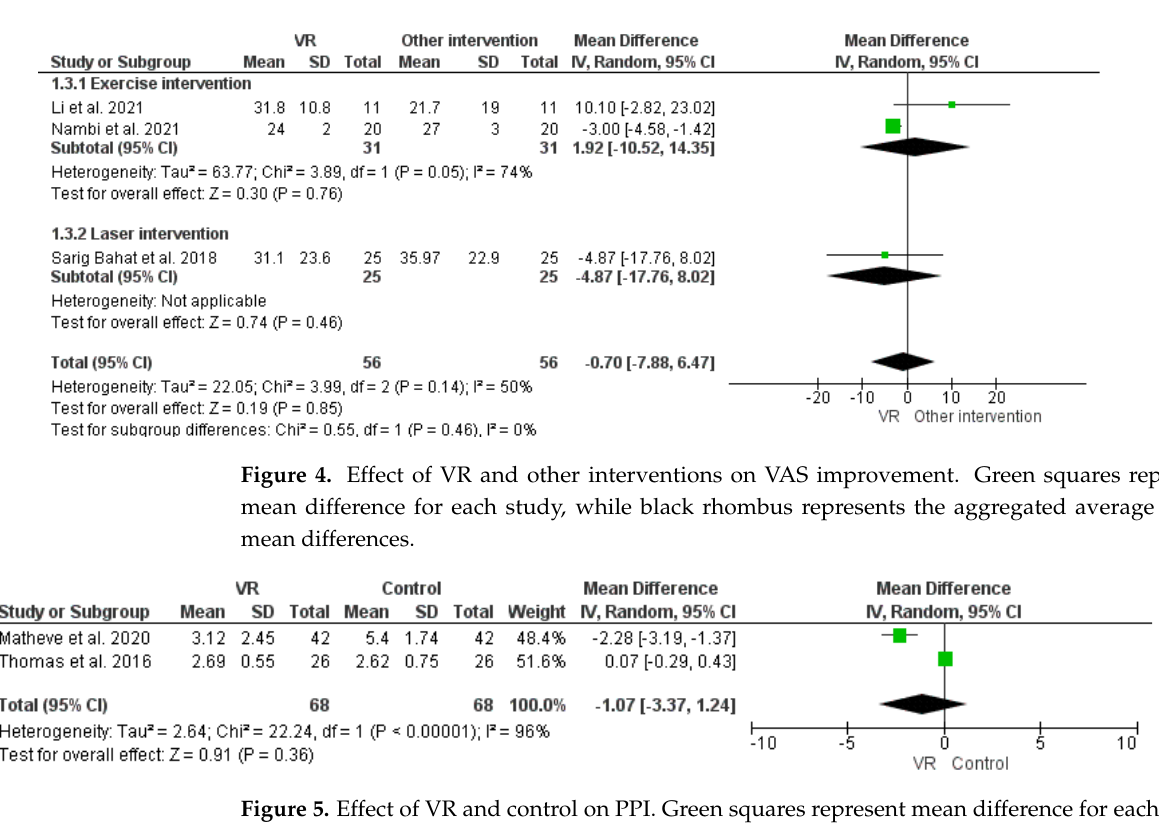
Figure 6. Effect of VR and control intervention on TSK outcome. Green squares represent mean difference for each study, while black rhombus represents the aggregated average of the mean differences.